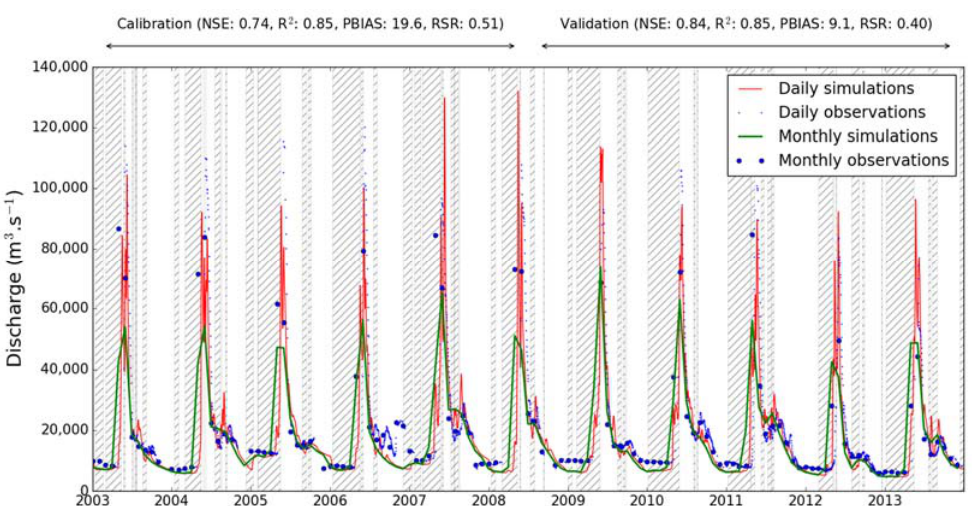
Figure 2. Simulation at a monthly time step at the Yenisei outlet compared to the daily simulation and observations shown in Figure 1 with goodness of indices for the monthly simulation. The peaks are not as well represented but the dynamic low flows are still respected. The hatched zones represents the periods where the monthly modeled discharge is higher than the daily modeled discharge.